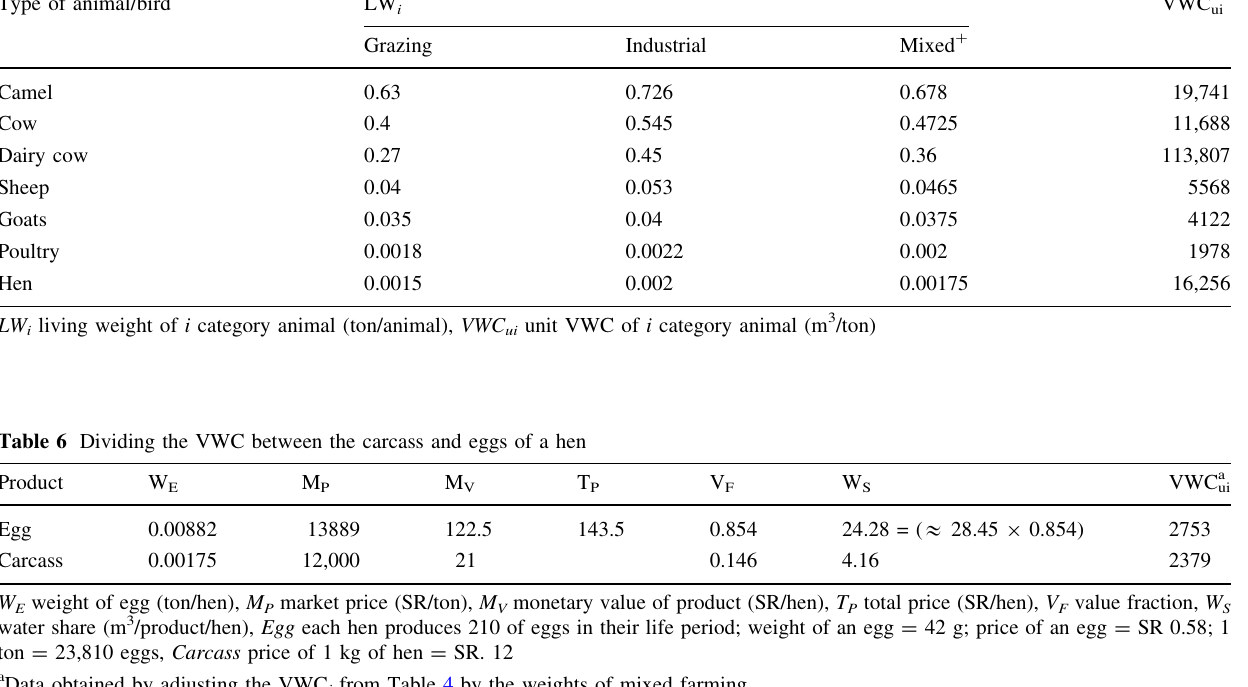
Table 5 Calculation of VWC for unit weight of a livestock animal meat at slaughtering age Type of